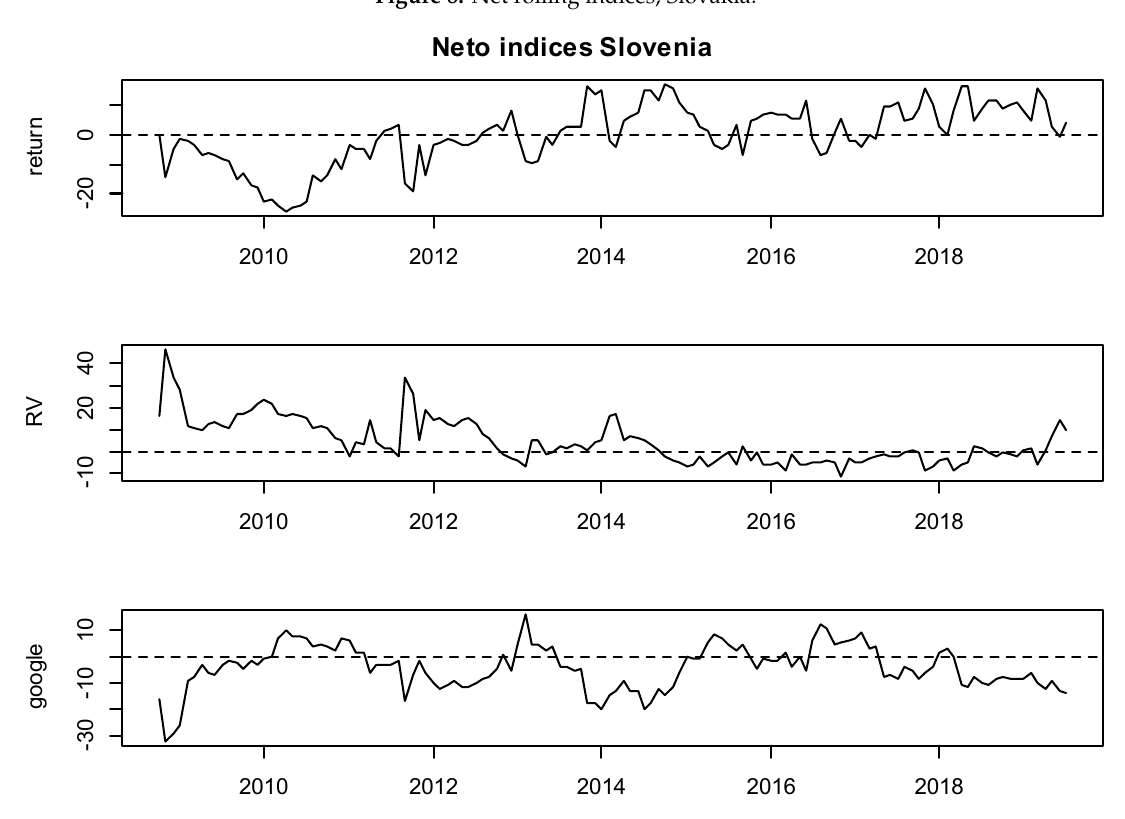
Figure 8. Net rolling indices, Slovakia.